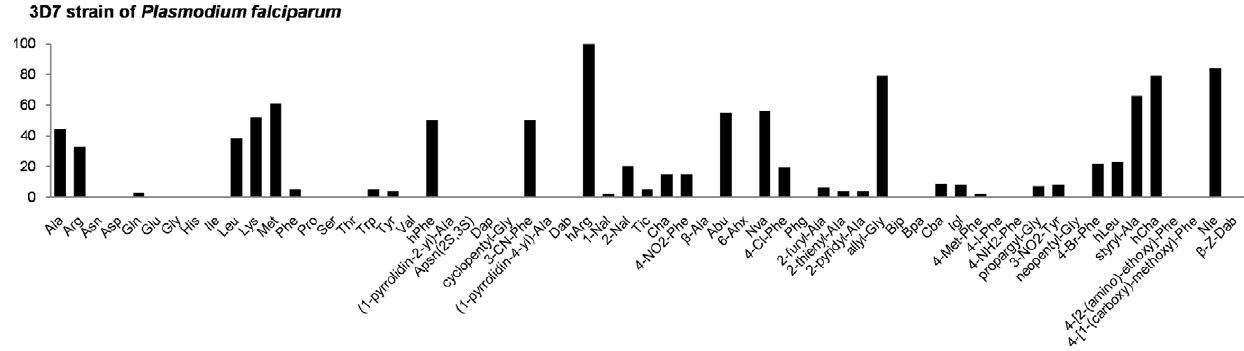
Figure 4. Total aminopeptidase activity explored in the 3D7 clone of P.falciparum in the absence (A). Aminopeptidase activity in soluble malaria parasite extracts was monitored using an fmax multi-well fluorescence plate reader (Molecular Devices) at excitation wavelength of 355 nm and an emission wavelength of 460 nm. The x-axis represents the abbreviated amino acid names (for full name and structure see Figure S1). The y- axis represents the average relative activity expressed as a percent of the best amino acid. Note, the addition of the aminopeptidease-specific inhibitor hPhe-PO 3 H 2 (50 m M) to any of the above experiments completely abrogated cleavage of every substrate, thus confirming that the observed signal originates only from these enzymes.